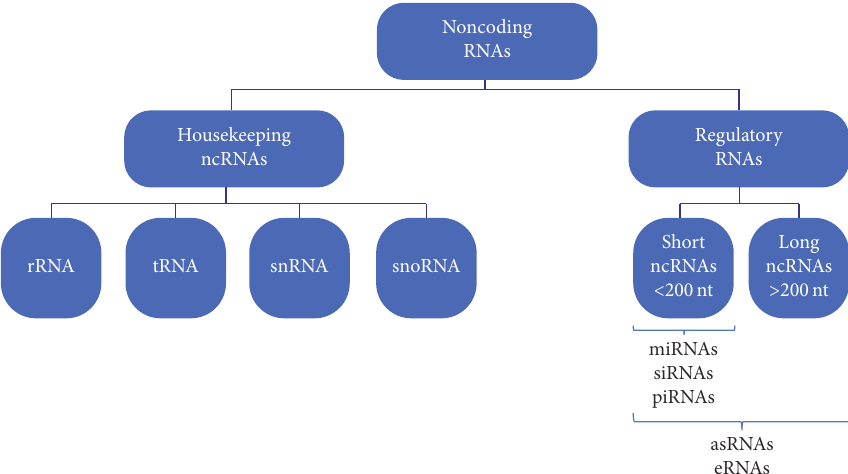
Figure 2: Types of noncoding RNAs (ncRNAs). Noncoding RNAs are classified into housekeeping and regulatory noncoding RNAs. Housekeeping ncRNAs include ribosomal (rRNA), transfer (tRNA), small nuclear (snRNA), and small nucleolar RNAs (snoRNAs). Regulatory noncoding RNAs are divided into short ncRNAs ( < 200 nucleotides) or long ncRNAs ( > 200 nucleotides) including microRNAs (miRNAs), small interfering RNAs (siRNAs), Piwi-associated RNAs (piRNAs), antisense RNAs (asRNAs), and enhancer RNAs (eRNAs).